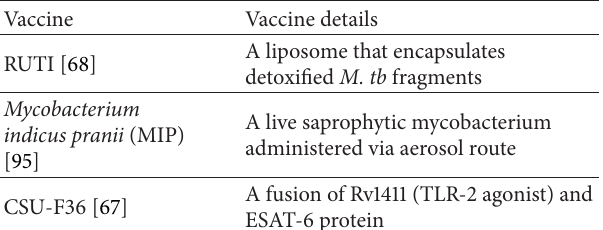
Table 2: Candidate emerging therapeutic TB vaccines and its brief